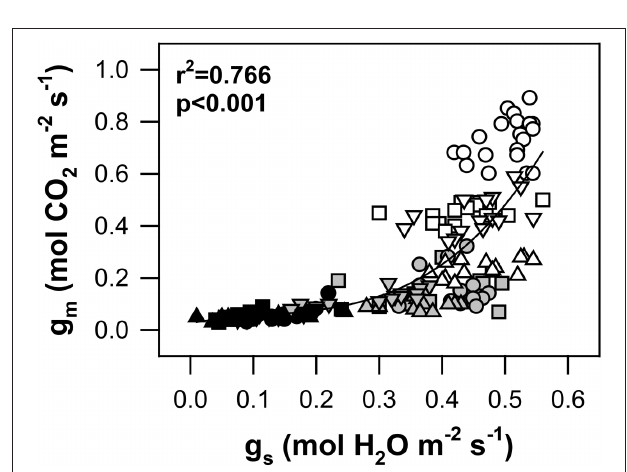
FIGURE 6 | The relationship between the stomatal conductance to H 2 O (g s , mol H 2 O m − 2 s − 1 ) and mesophyll conductance to CO 2 (g m , mol CO 2 m − 2 s − 1 ) in the leaves of four wheat genotypes under progressive drought. The symbols are the same as in Figure 2 . Data were fitted by a non-linear regression (full line). The equation is g m = 0.426 g s − 2.129 g 2 s + 6.189 g 3 s , and the coefficient of determination ( r 2 ) and significance ( p ) are shown ( n = 161) in the